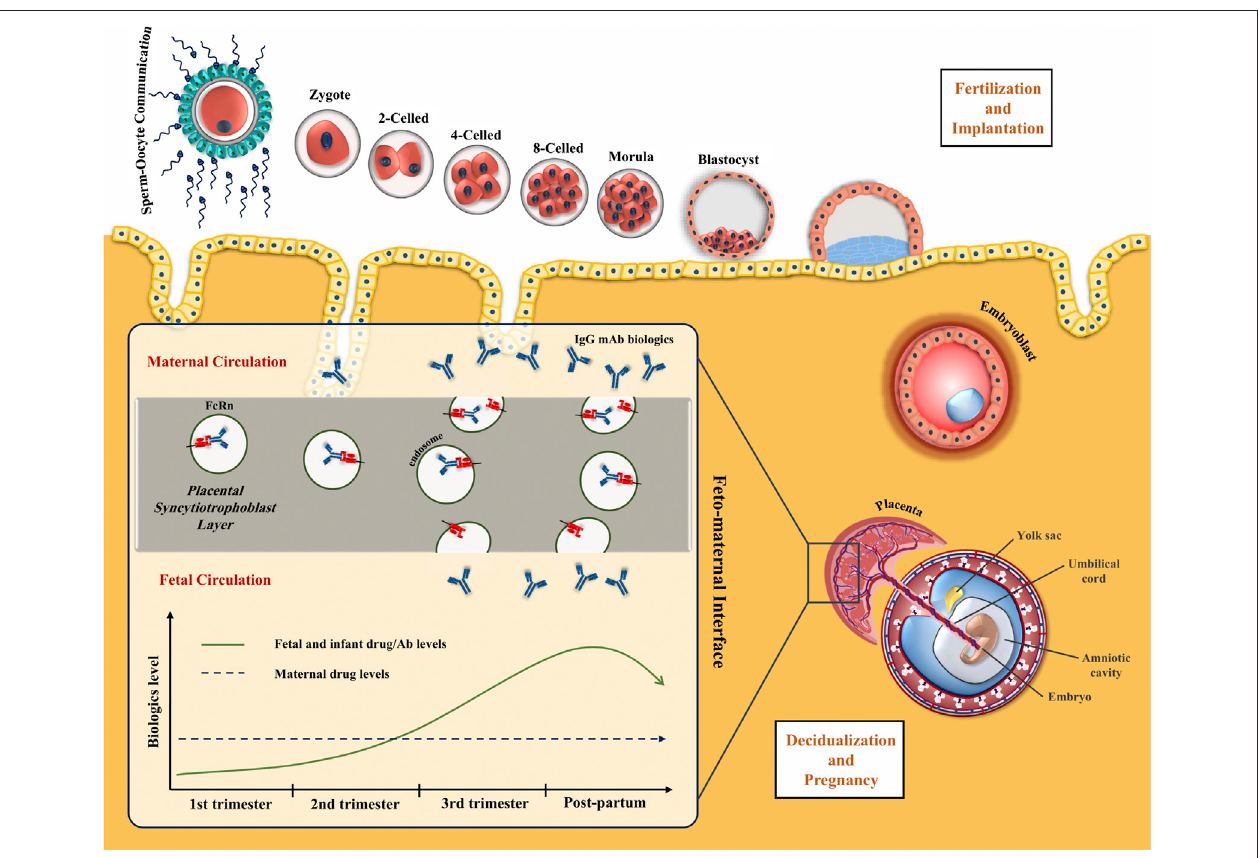
FIGURE 1 | Placental transfer of IgG mAbs. IgG is the only antibody class that crosses the placenta through the syncytiotrophoblast layer. FcRn internalizes the maternal IgG in the endosome and releases it on the other side of the syncytiotrophoblast layer. IgG transmission signi fi cantly increases during the third trimester of